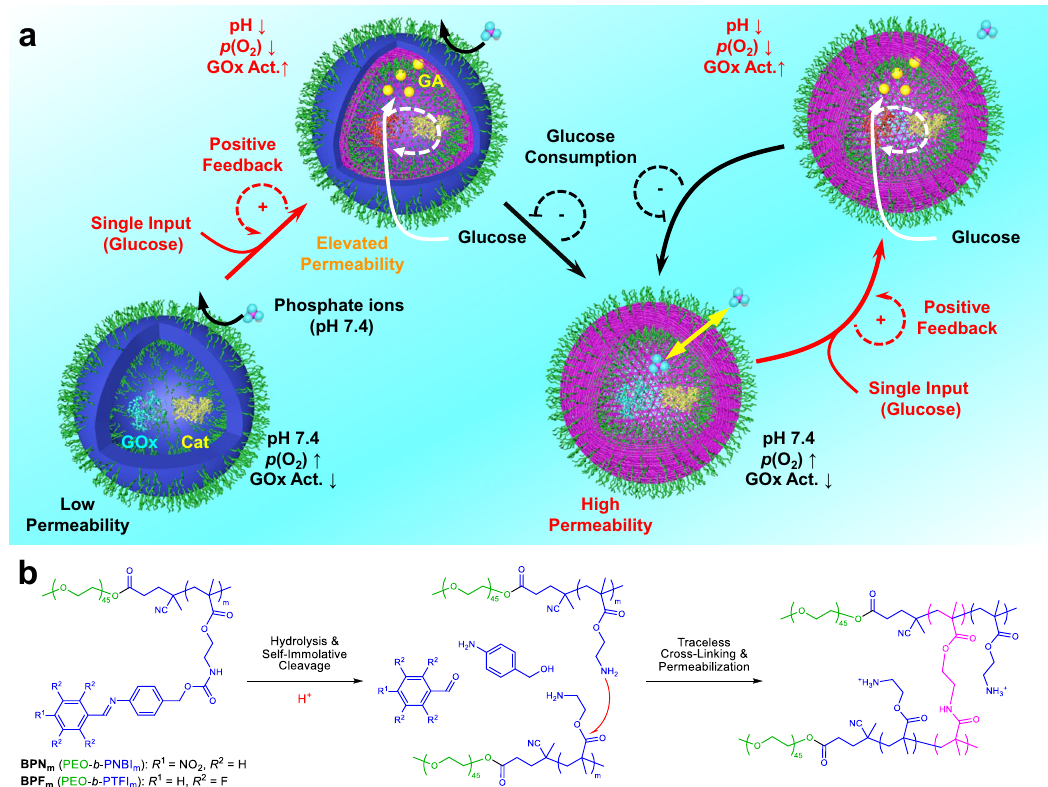
Fig. 1 Glucose-fueled self-catalyzed construction of transient acidic milieu within the aqueous lumen of enzyme-loaded polymersomes via self-